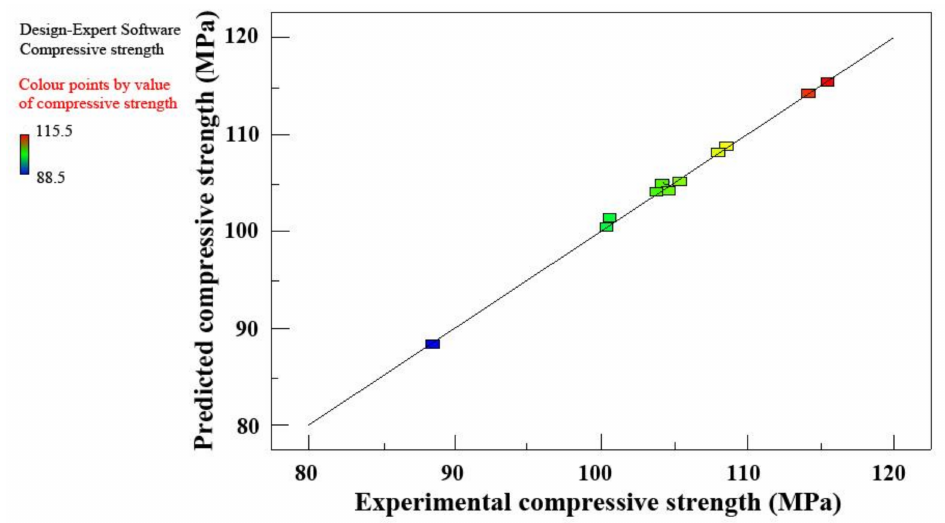
Figure 11. Predicted compressive strength vs. experimental compressive